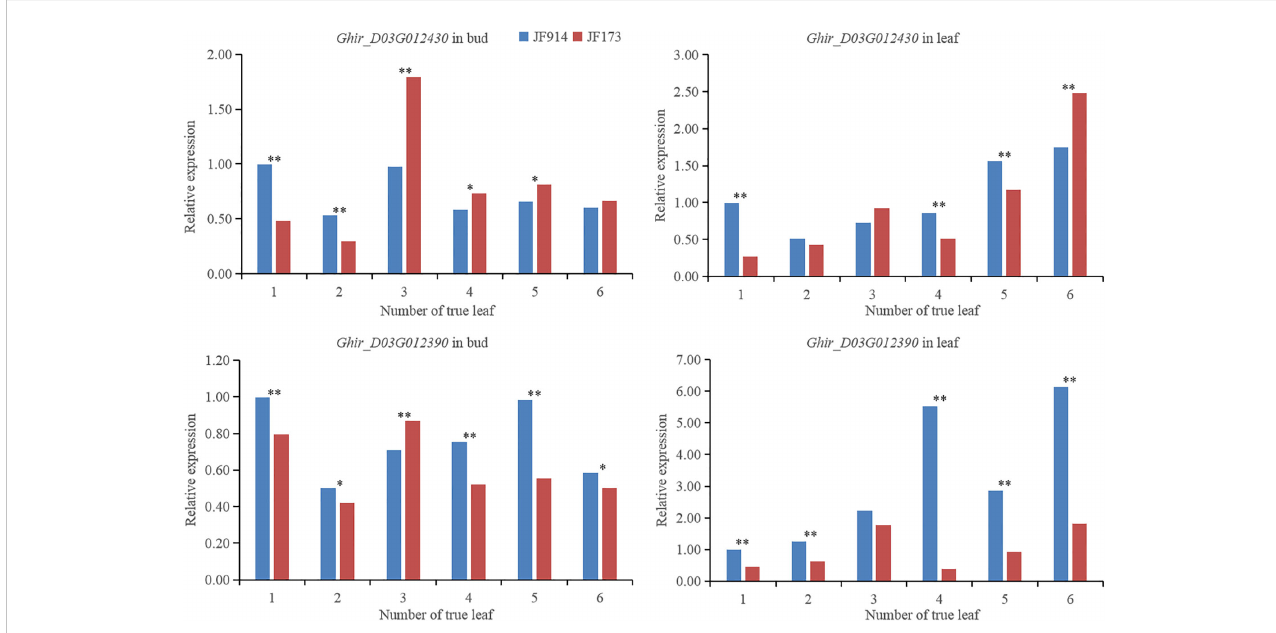
FIGURE 4 Gene expression level in the bud and leaf of JF914 and JF173. *, the difference reached p =0.05 signi fi cance level; **, the difference reached p =0.01 signi fi cance